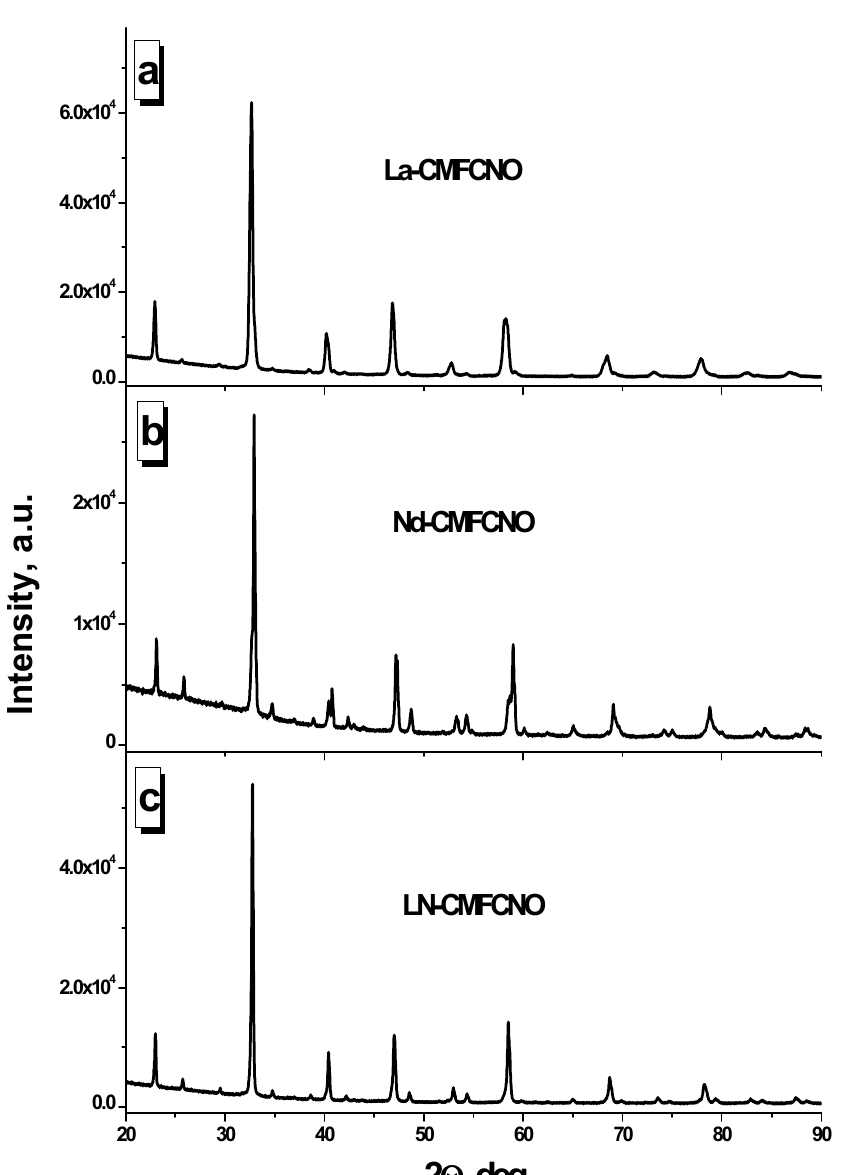
Figure 1. X-ray diffraction (XRD) patterns of the La-CMFCNO ( a ), Nd-CMFCNO ( b ) and LN- CMFCNO ( c ) ceramic samples.